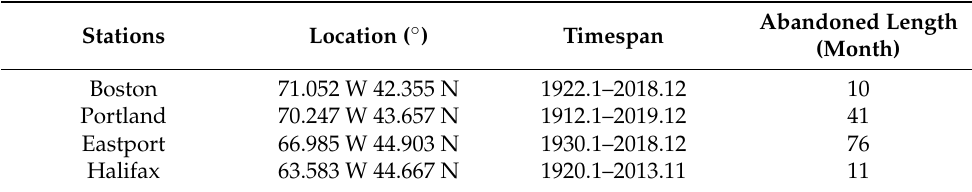
Figure 1. The location of tide gauges (represented by “*”) and topography of the Gulf of Maine and Bay of Fundy. Water depth deeper than 250 m is shaded in dark blue. Table 1. Information for the four tide gauges.